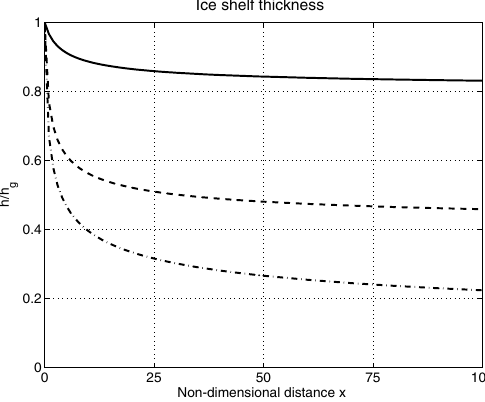
Figure 4. Steady-state ice-shelf profiles in the limit of zero net ablation, given by Eq. (13). The depth is normalized with the grounding-line depth h g and the non-dimensional distance is de- fined as x(µ 3 h 3 g /u g ) . The solid, dashed, and the dashed-dotted lines represent h b /h g = 0.8, h b /h g = 0.4, and h b /h g = 0.0, respectively. At large distances, the ice-shelf thickness approaches the back- pressure thickness h b , implying that without back pressure ( h b = 0) the ice-shelf thickness shrinks to zero far away from the grounding